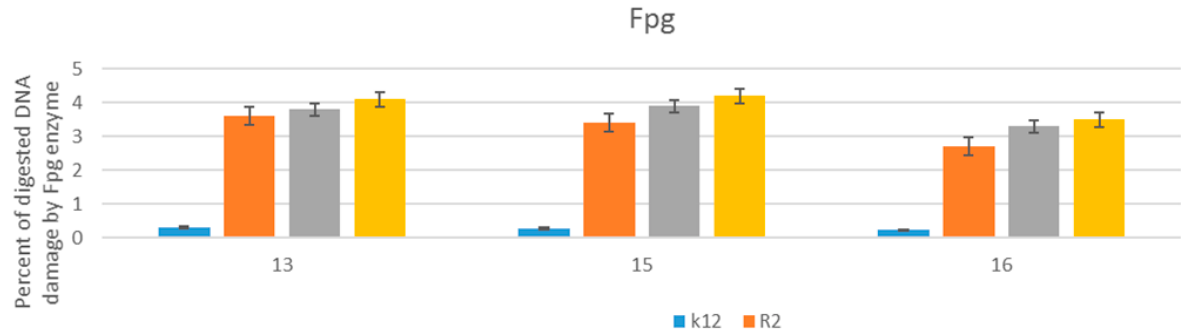
Figure 6. Percentage of plasmid DNA recognized by the Fpg enzymes ( y -axis) with model bacterial, K12, and R2–R4 strains ( x -axis). All analyzed compounds numbered were statistically significant at <0.05 (see Table 2).